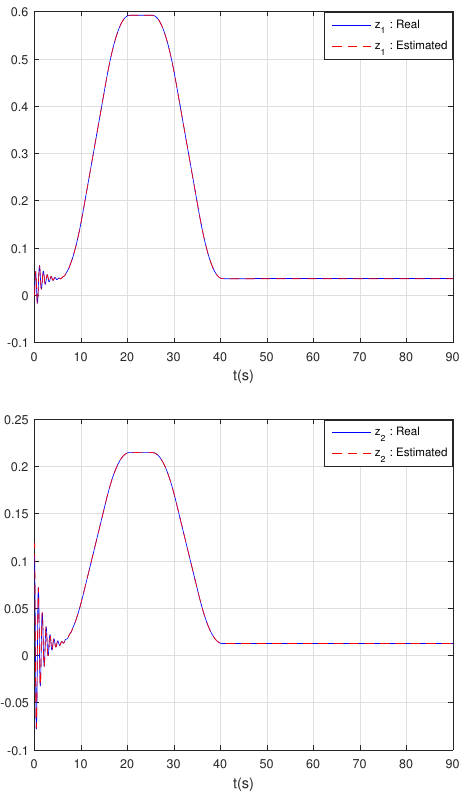
Figure 1. z 1 and z 2 with their estimates.